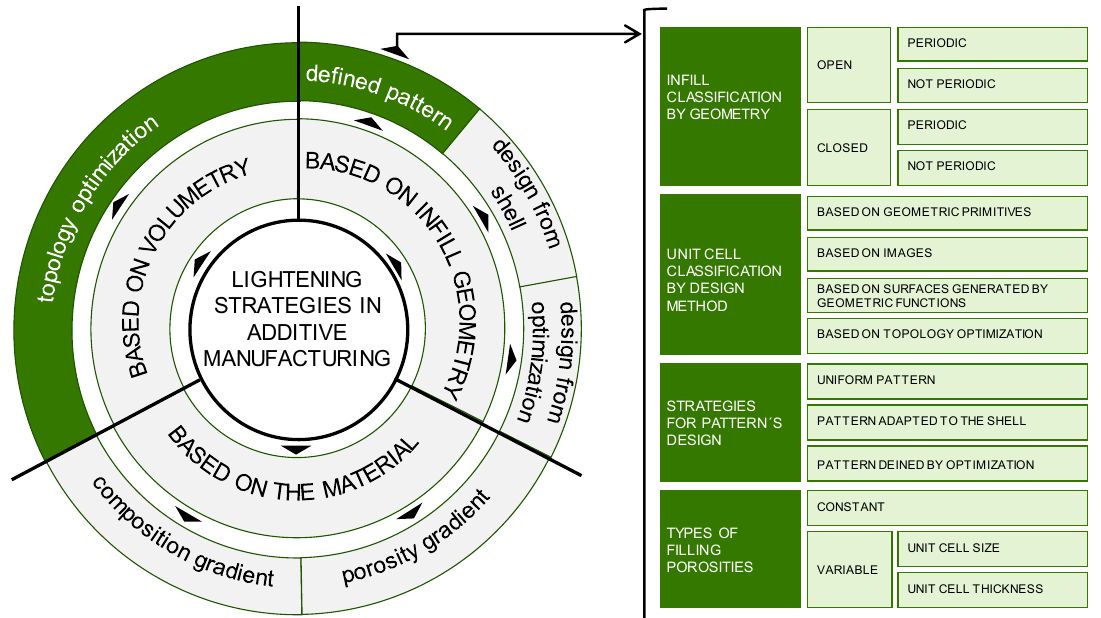
Figure 2. Classification of the lightening strategies of pieces produced by additive manufacturing.